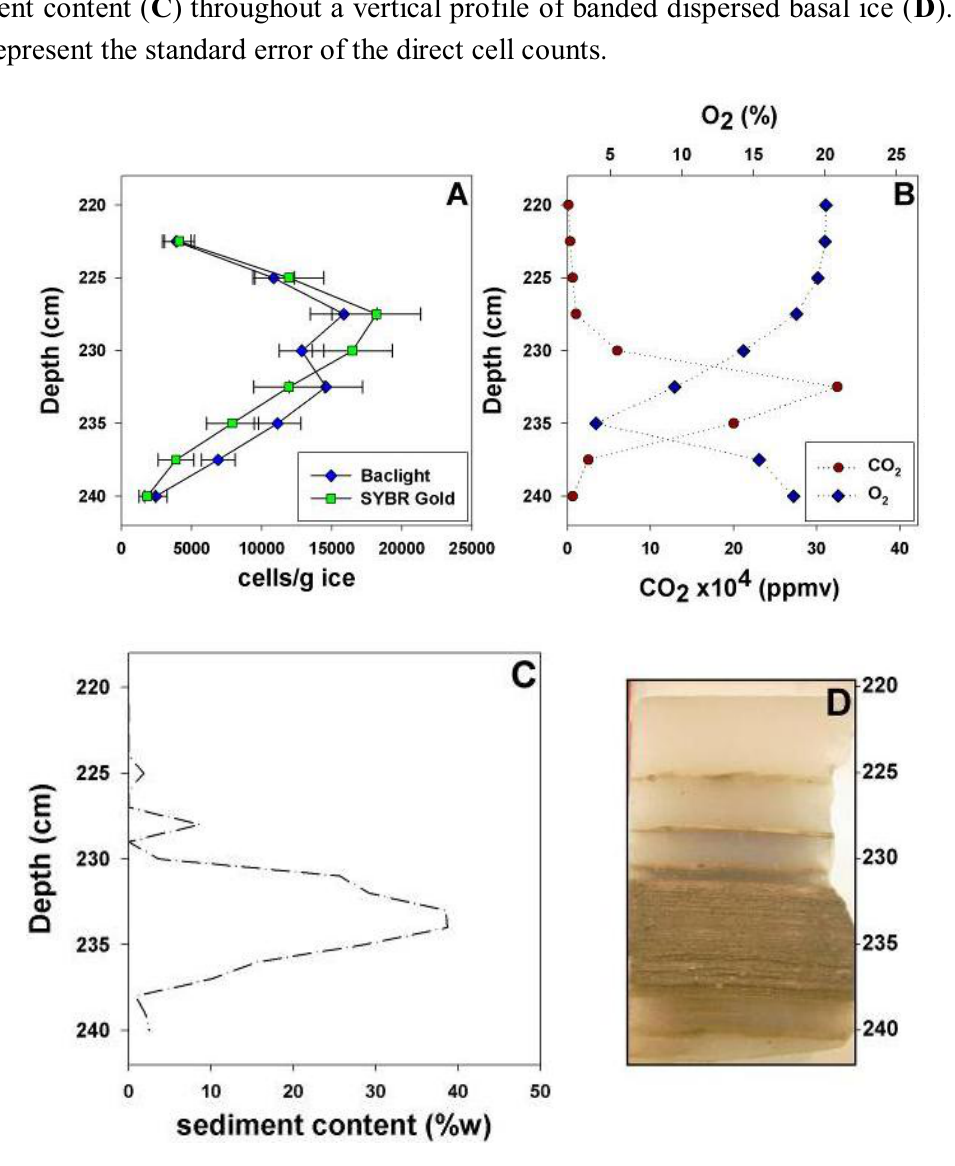
and CO ( B ) and 2 2